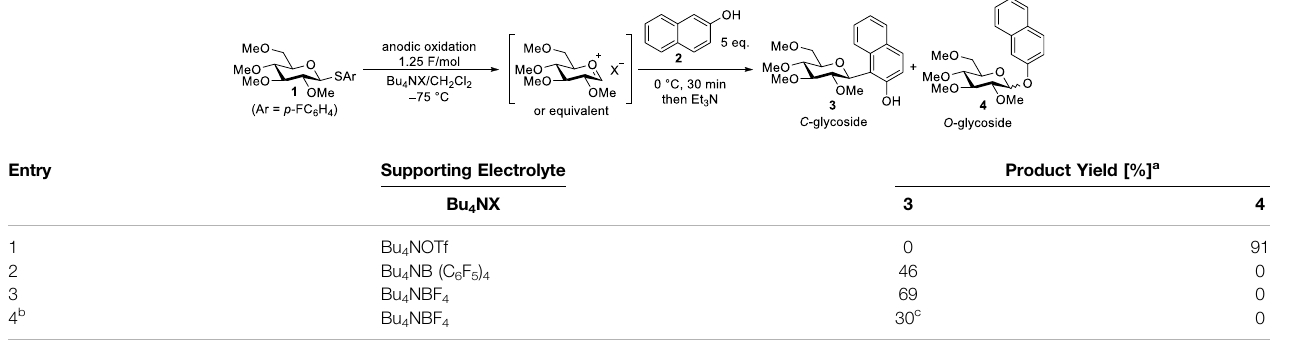
TABLE 1 | Screening of supporting electrolyte for electrochemical C -glycoside synthesis in the batch reactor.